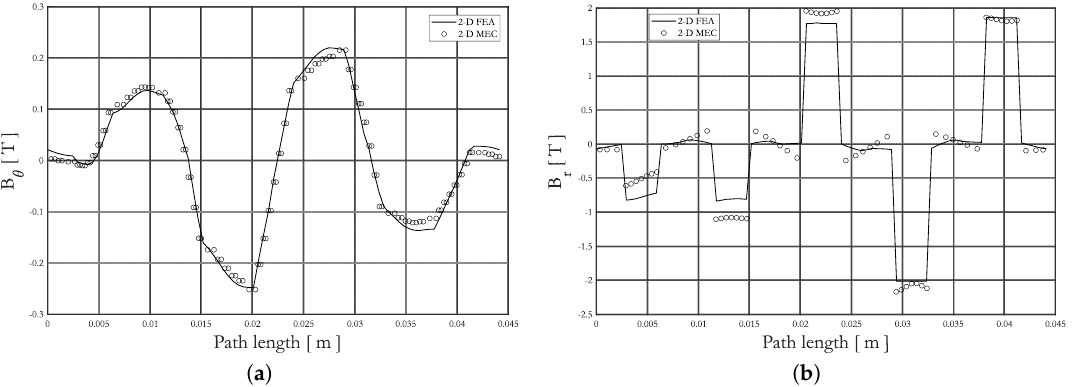
Figure 8. Waveform of B in the stator teeth: ( a ) tangential, and ( b ) radial